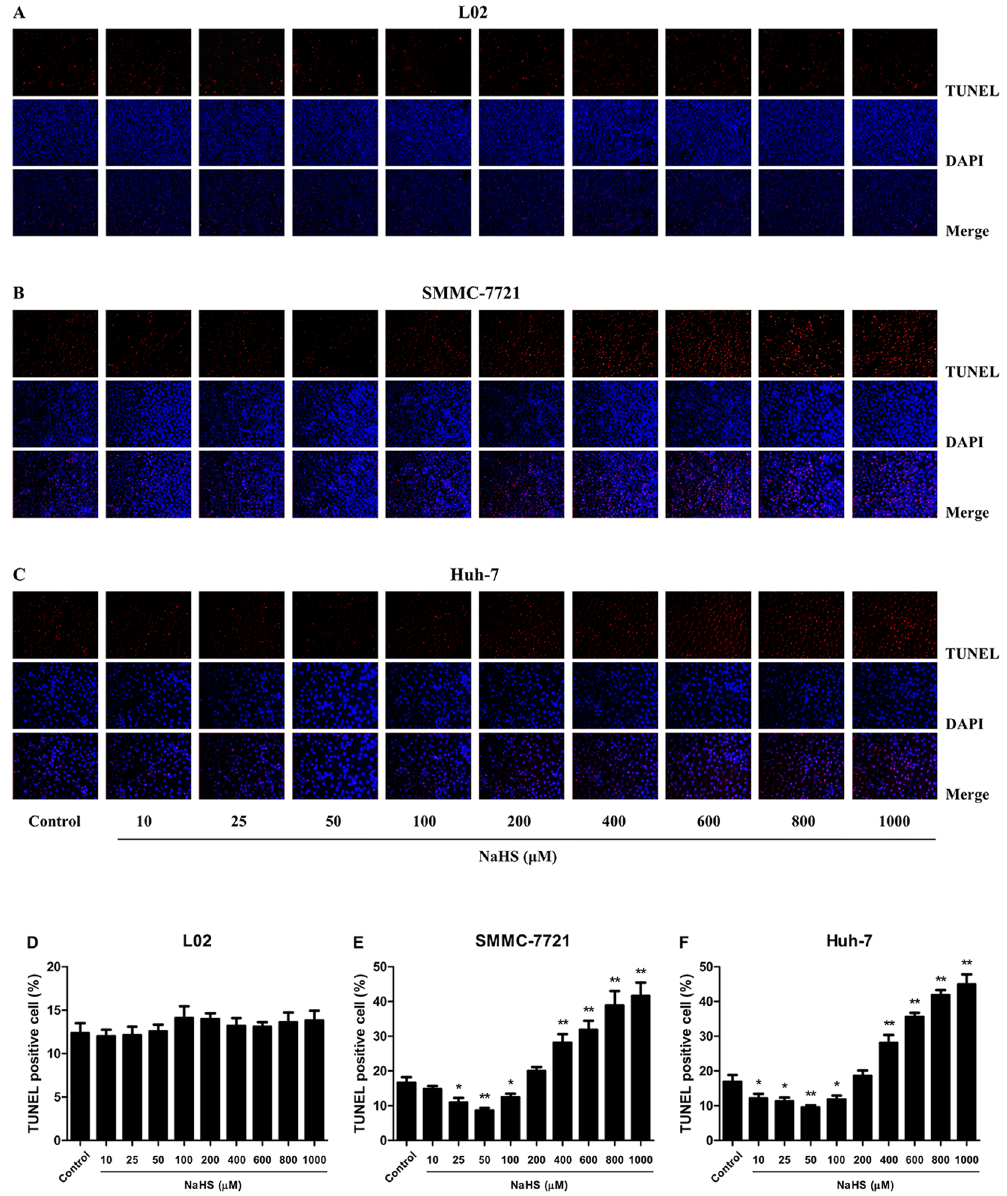
Figure 4. Effect of H 2 S on the apoptosis of normal human hepatocytes and HCC cells. ( A – C ) The human normal hepatocyte cell line L02 and HCC cell lines SMMC-7721 and Huh-7 were seeded into 6-well plates at 2 × 10 5 cells/well. After incubation with NaHS at 0 (Control), 10, 25, 50, 100, 200, 400, 600, 800, or 1000 μ M for 24 h, apoptosis was measured by TUNEL staining; original magnification 200x. ( D – F ) The percentages of TUNEL-positive cells were calculated. Data are presented as mean ± SEM of three independent experiments; * P < 0.05, ** P < 0.01 compared with the control